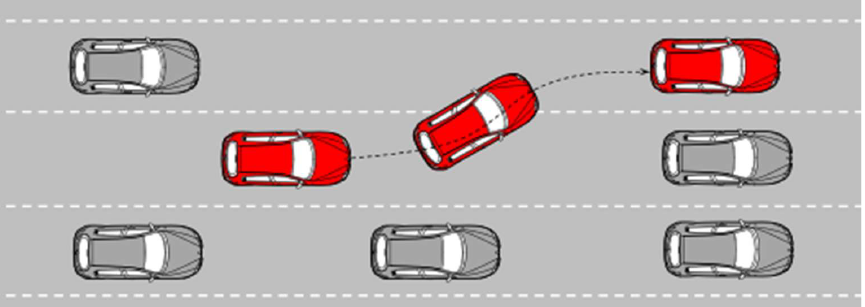
Figure 4. Schematic diagram of vehicle lane-changing.